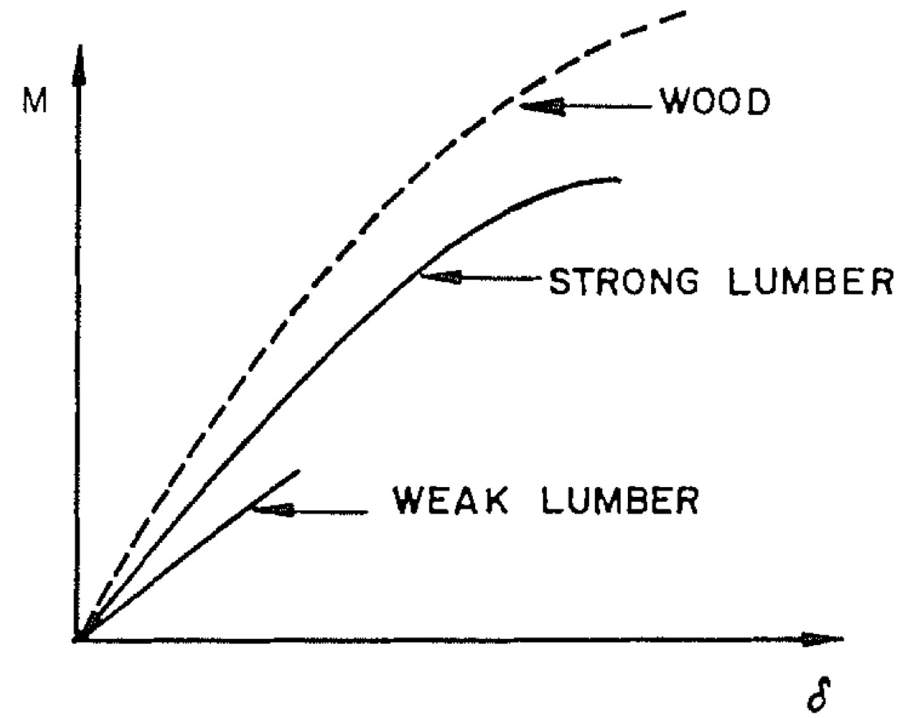
Figure 17. Schematic comparisons of load-deflection curves in bending for defect-free (clear) wood, ‘strong’ and ‘weak’ lumber. From [86].